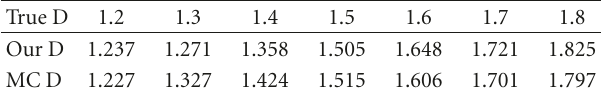
Table 9: Estimated FD of WCF